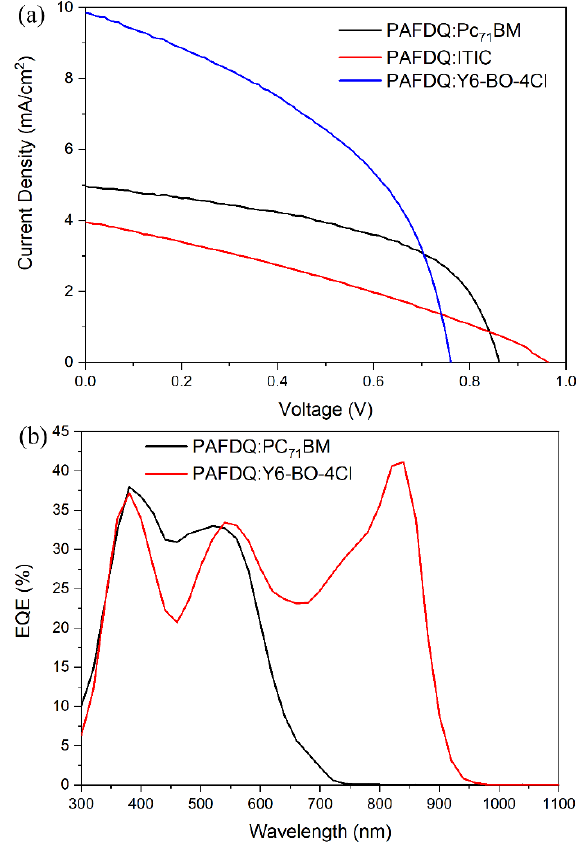
Figure 4. Photovoltaic performance of organic solar cells (OSCs). ( a ) J-V curves and ( b ) external quantum efficiency (EQE) spectra. Table 2. Photovoltaic performance of the OSCs .